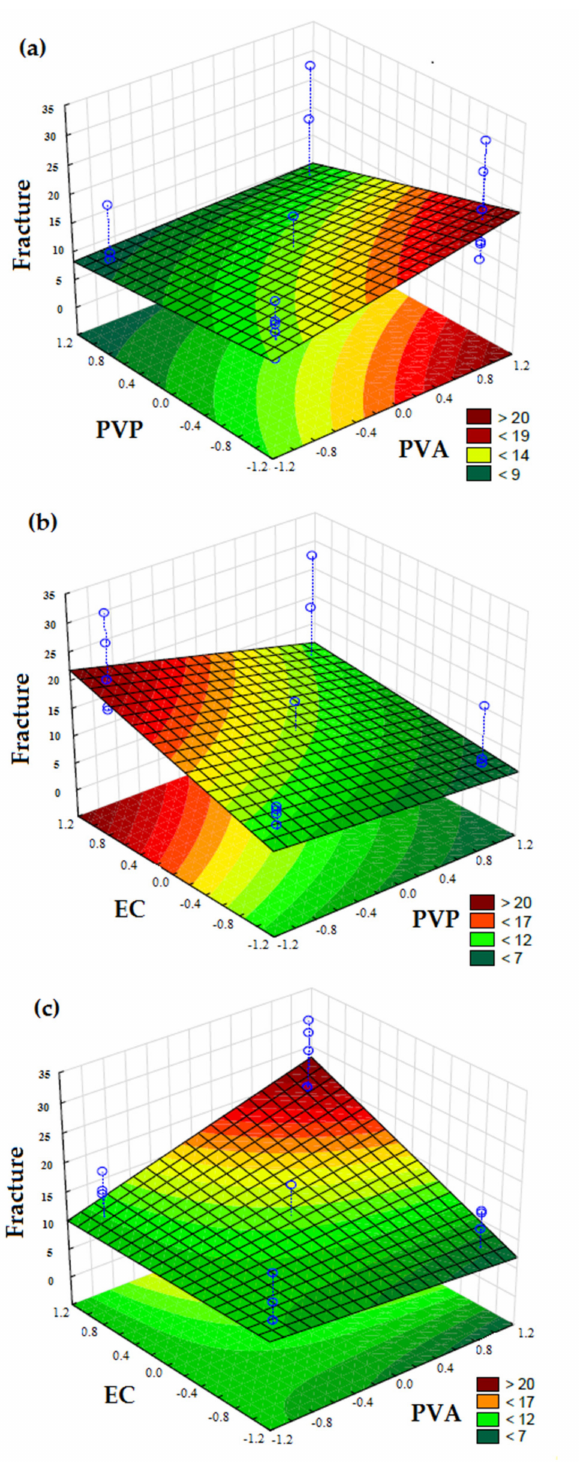
Figure 3. Response surface plots of mechanical tensional characteristic (Fracture) of film formulations at 25 ◦ C as a function of: ( a ) PVA (X 1 ) and PVP (X 2 ); ( b ) PVP (X 2 ) and EC (X 3 ); ( c ) PVA (X 1 ) and EC (X 3 ). The color scale is indicated in each figure and shows the isoparametric